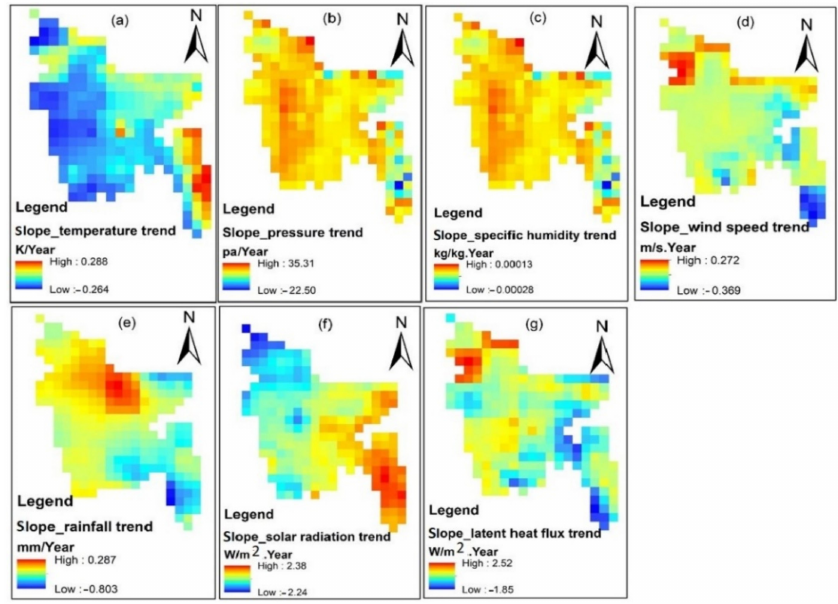
Figure 6. Trend analysis of meteorological parameters over Bangladesh for the period of 2015–2020: ( a ) temperature, ( b ) pressure, ( c ) specific humidity, ( d ) wind speed, ( e ) rainfall, ( f ) solar radiation, and ( g ) latent heat flux.